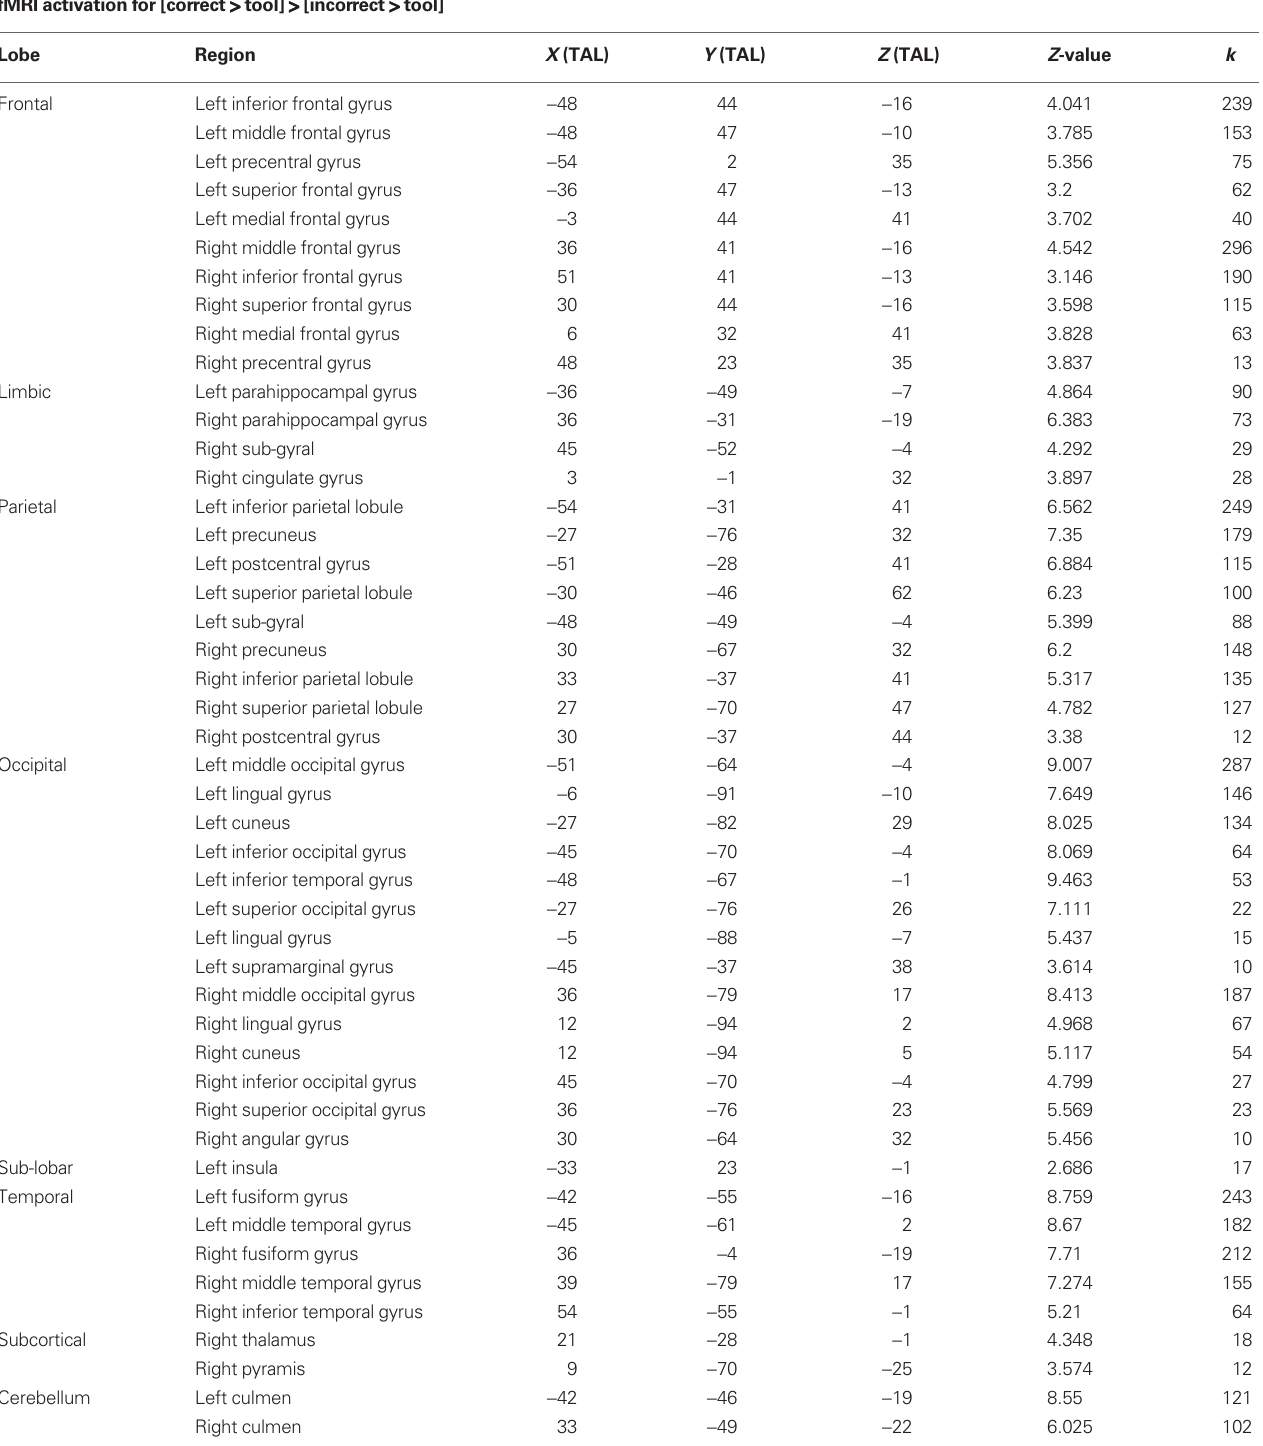
Table 1 | Functional magnetic resonance imaging activations specific to [correct > tool] > [incorrect > tool]. fMRI activation for [correct > tool] > [incorrect >